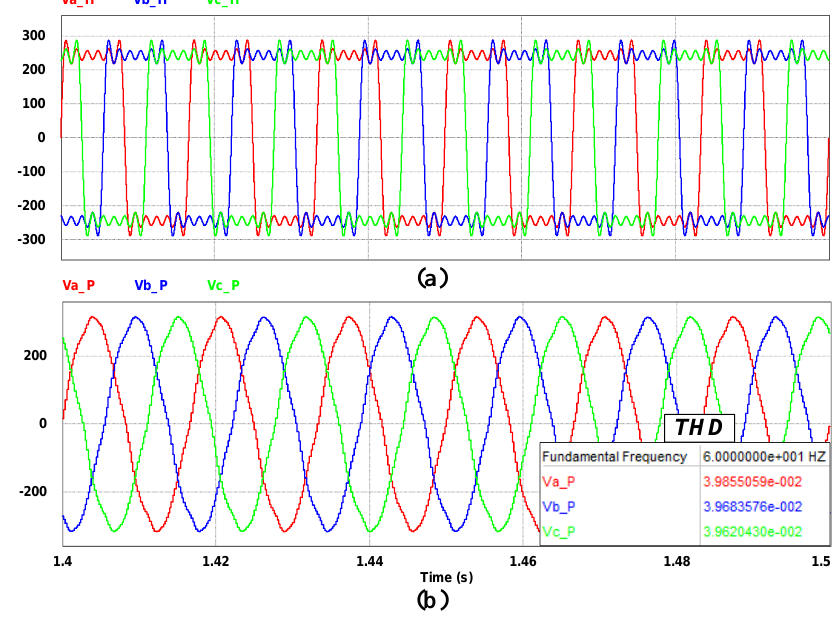
Figure 17. Waveform of voltage when harmonics is included in input side; ( a ) the 3-phase input voltage with harmonic components; and, ( b ) the 3-phase input voltage detected by the SOGI-FLL.